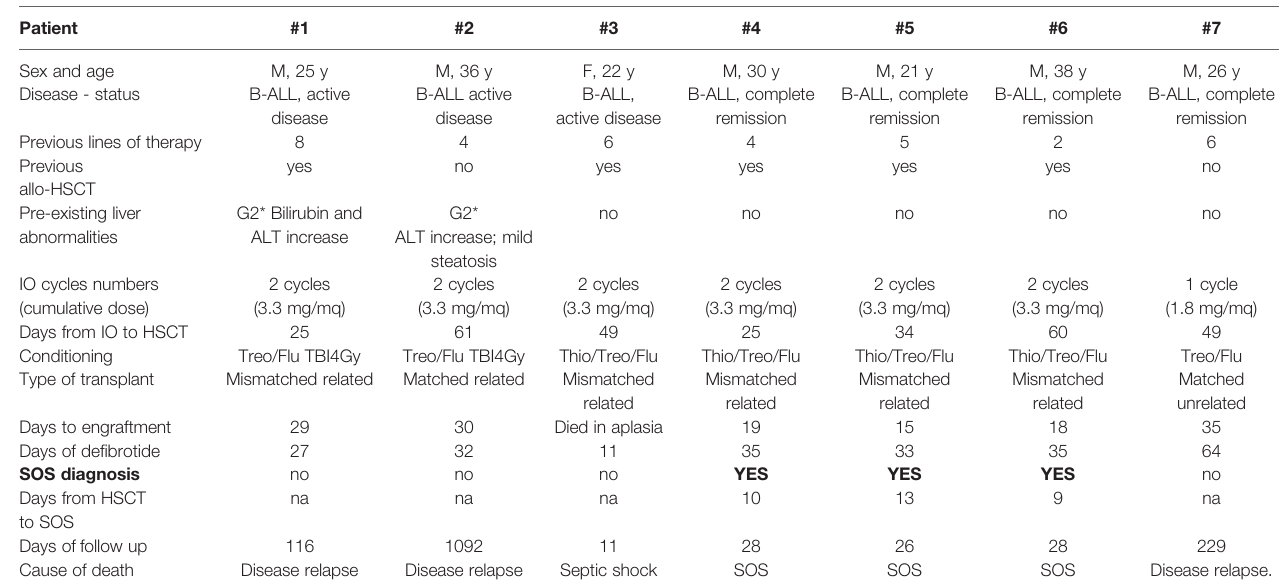
TABLE 1 | Patient, disease, and treatment